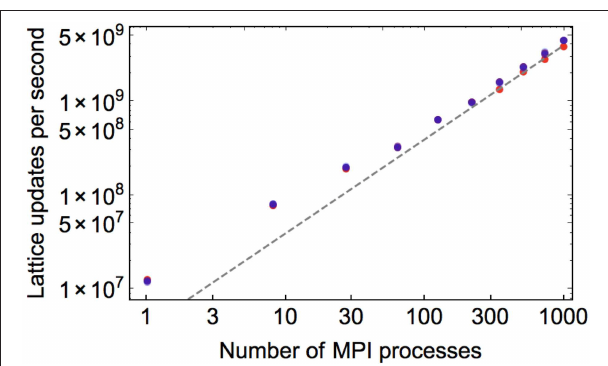
FIGURE 4 | Weak scaling performance of openQmin on Comet, in total number of lattice site updates [i.e., (time steps) (ranks) ( N p )] per second vs. × × the number of CPU processes, P , for a constant number of lattice sites per process. The points from dark red to light blue correspond to N p 75 3 , 100 3 , 125 3 , 150 3 , 250 3 lattice sites per rank. The dashed gray = P line corresponds to ideal ∝